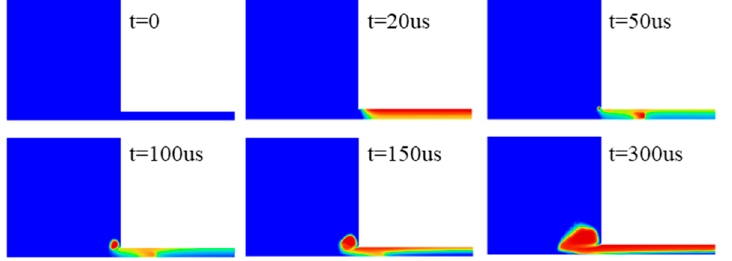
Figure 4. Variation in the vapor fraction over time (gap = 0.25 mm, amplitude = 30 μ m).